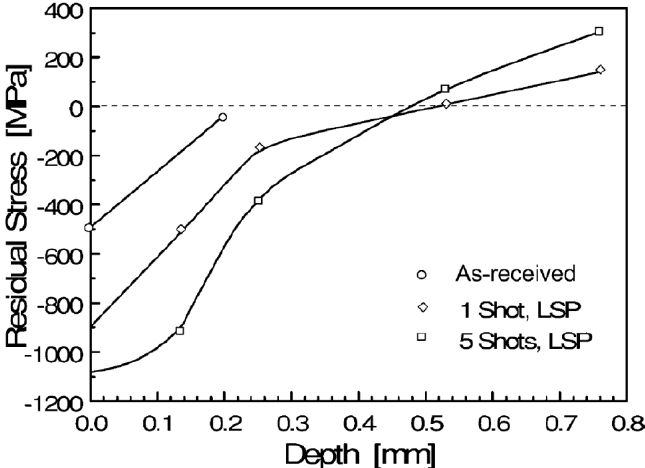
Figure 8. Residual stress profiles in 1.5 mm 4340 steel sheet for as received, one and five laser shocks